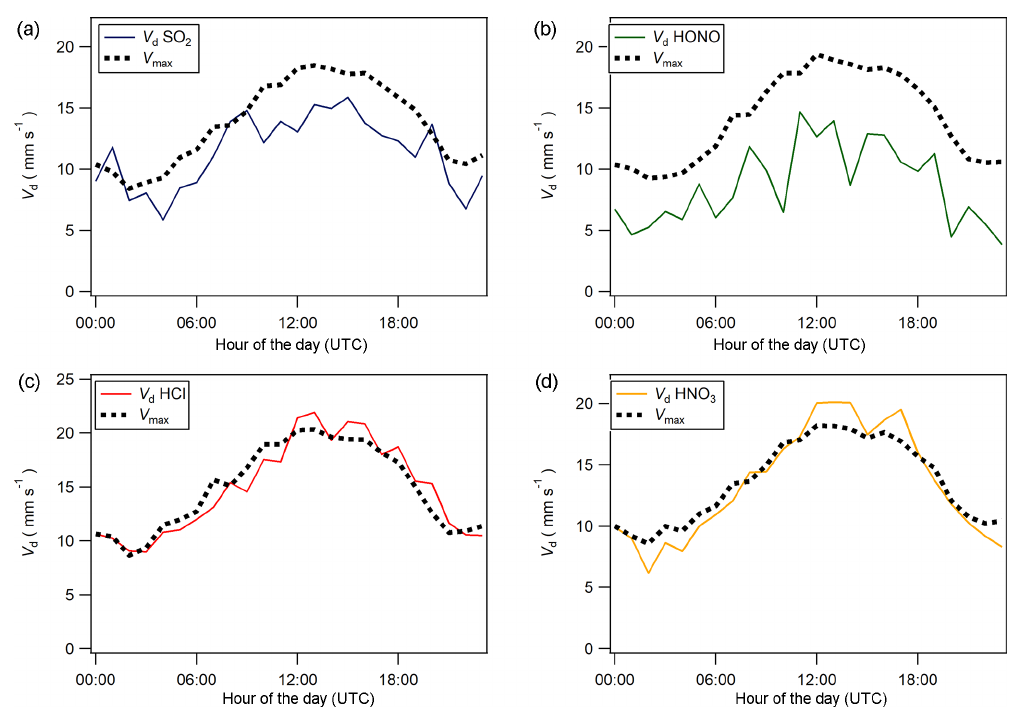
Figure 8. Median diel cycles for deposition velocity ( V d ) and maximum deposition velocity ( V max ) for (a) SO 2 , (b) HONO, (c) HCl, and (d) HNO 3